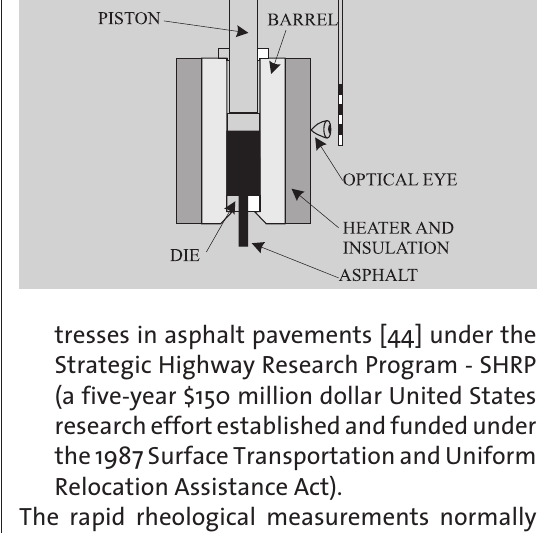
Figure 1: Schematic diagram showing the main parts of the Flow Measurement Device (FMD) that is used for determining the Materi- al’s Volumetric-Flow Rate